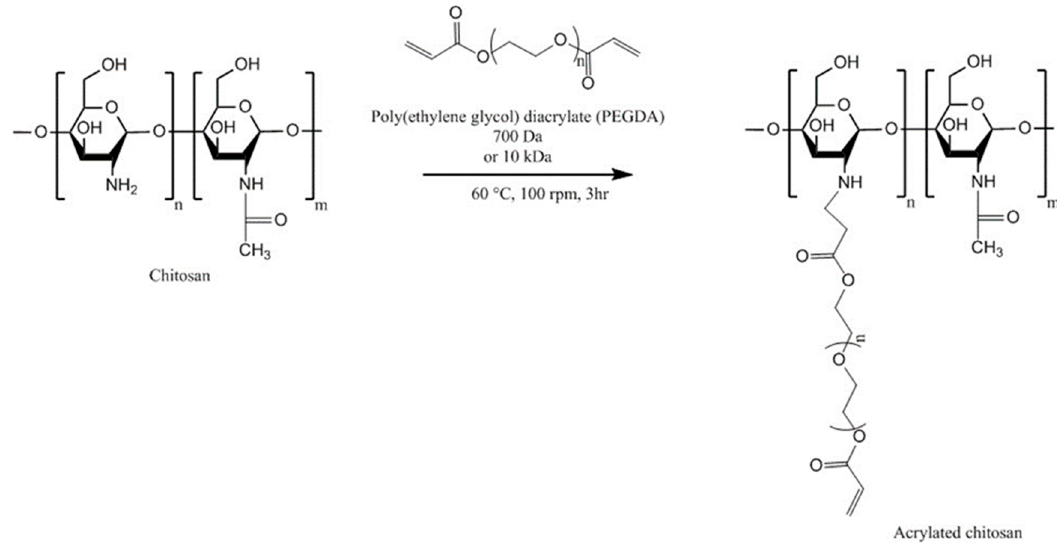
Figure 11. Synthetic pathway to acrylated chitosan [119].